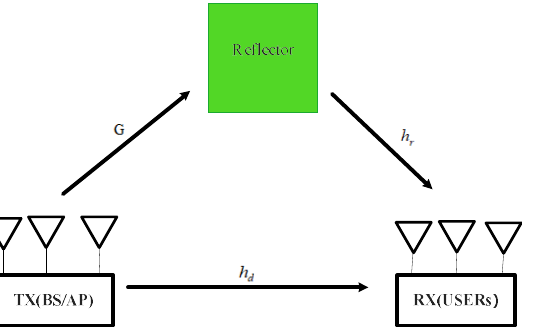
Figure 4. (A)lock diagram of OFDM/SC-FDE iterative FDE receiver. (B) IB-DFE receiver structure . System Model and Receiver Design of Receivers